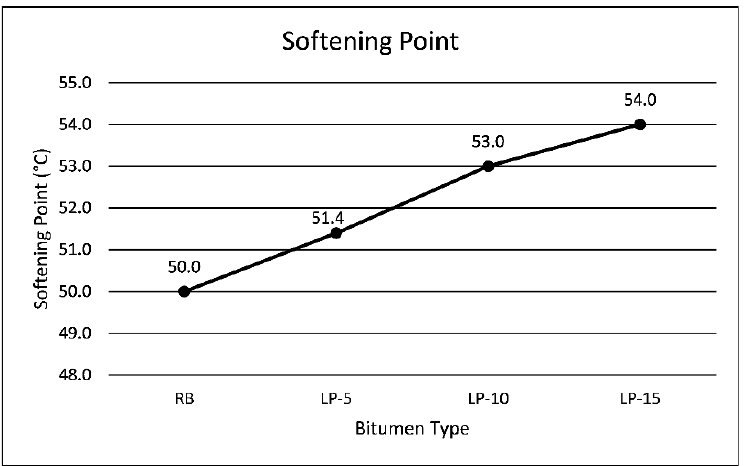
Figure 12. Softening point results .